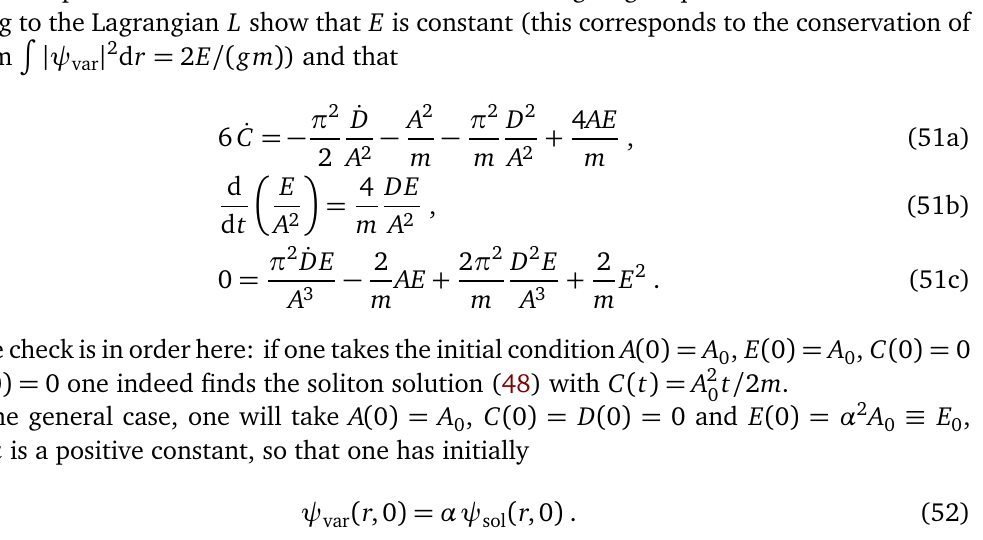
(cid:126) M ( r , t ) in the isotropic LL problem at Figure 19: Components of the magnetization t = 200 (green lines) compared with a self-similar solution (see text) parametrized by E (purple lines). The value of E is chosen so that both profiles have the same energy density at r = 0 (and t = 200). For t = 200 we have ε ( r = 0, t ) · t (cid:39) 0.4798 (cid:112) (as can be seen in the upper panel of Fig. 13), and E = 4 ε · t (cid:39) 1.3854. (cid:112) AE . The Lagrange equations of motion